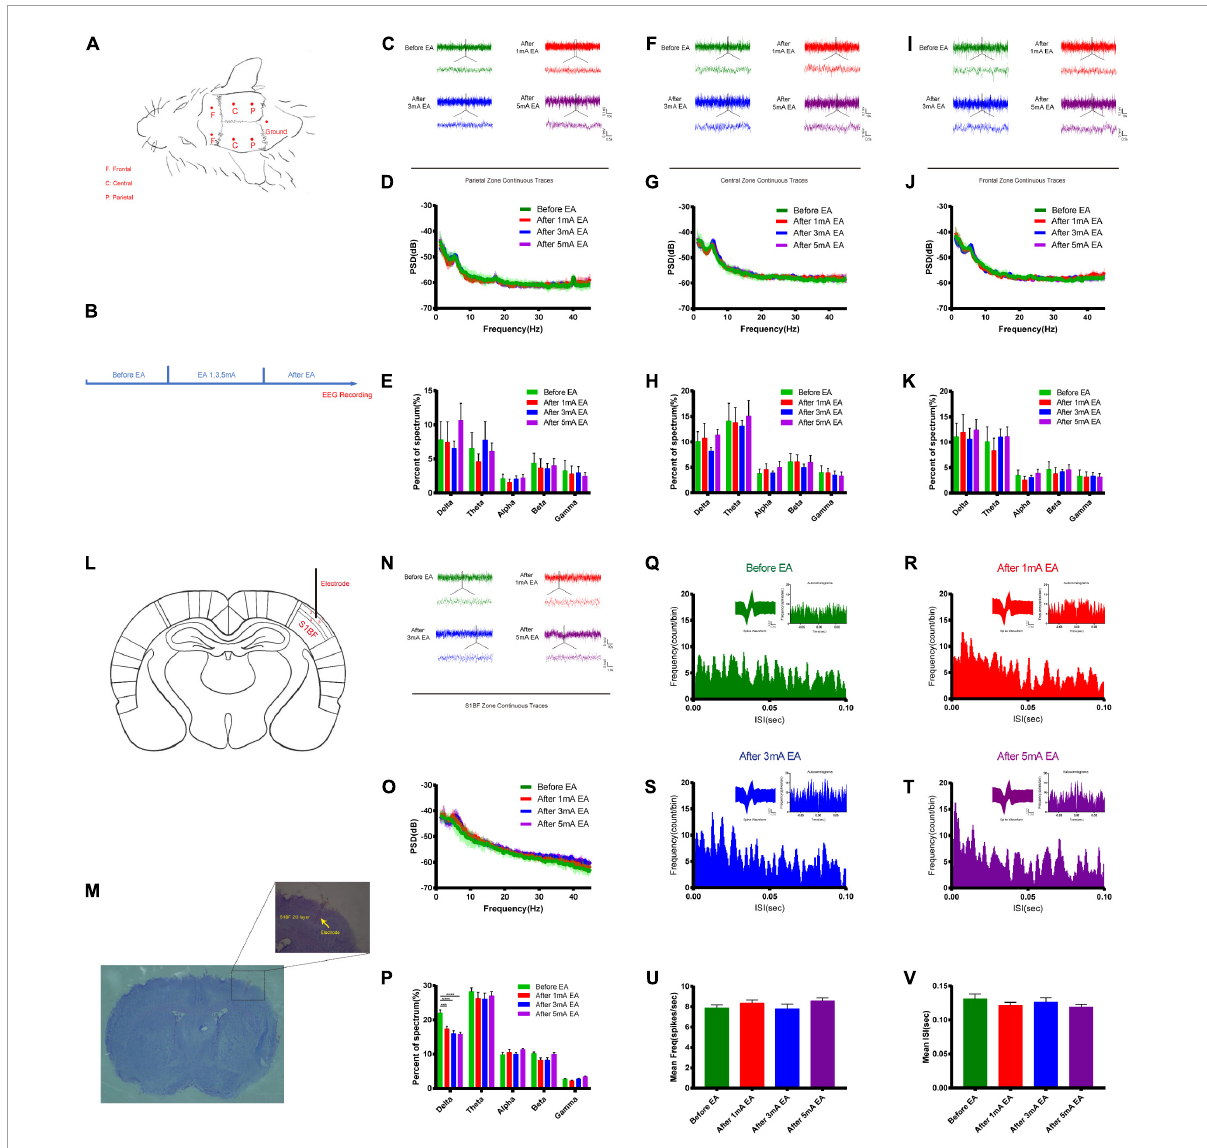
FIGURE6 Effect of different intensities of EA of trigeminal nerve on neuronal excitability changes in EEG. (A,B) EEG detection location and experimental flow. (C) Parietal zone continuous traces, 100 s of EEG data were selected in the stable state without interference for before EA and after EA groups (the EEG data during EA could not be used because of too much interference from electromagnetic radiation) and 5 s of data were captured for display. (D) PSD (power spectral density) in the parietal zone before and after EA at different intensities. There was no significant difference between the groups. (E) Parietal zone of each group for delta 1–3 Hz, theta 3–7 Hz, alpha 7–12 Hz, beta 12–30 Hz, and gamma 30–45 Hz frequency band percent of the spectrum (%), which showed that there was no significant difference. (F) Central zone continuous traces, 100 s of EEG data were selected and 5 s of data were captured, for display. (G) The PSD central zone before and after EA of different intensities. There was no significant difference between the groups. (H) Central zone for each group frequency band percent of the spectrum (%); there was no significant difference for each group. (I) Frontal zone continuous traces, 100 s of EEG data were selected and 5 s of data were captured for display. (J) The PSD frontal zone before and after EA of different intensities. There was no significant difference between the groups. (K) Frontal zone group frequency band percent of the spectrum (%); there was no significant difference for each group. Zone frequency band percent of the spectrum (%) for each group showed that there was no significant difference for each group, n = 5/group. (L,M) Electrode implantation in S1BF 2/3 layer zone (corresponding to the infraorbital nerve stimulation point). (N) S1BF zone continuous traces, 100 s of EEG data were selected and 10 s of data were captured for display. (O) PSD before and after different intensities of EA in the S1BF zone. (P) The group frequency band percent of the spectrum (%) showed that delta rhythm decreased after EA of the S1BF zone, *** P < 0.001, control group vs. 1 mA group, **** P < 0.0001, control group vs. 3 and 5 mA groups. (Q–T) The inter spike interval (ISI, bin = 0.05 ms) for different intensities of EA stimulation in the S1BF zone showed a typical waveform, and autocorrelograms indicated that the frequency of short ISI (less than 50 ms) increased with the increase in EA intensity. (U) The mean frequency of spike in unit time second for different intensities of EA stimulation in the S1BF zone for each group is shown, which indicates that there was no significant difference between the groups. (V) The mean ISI time for each group after EA of the S1BF zone, which showed no significant difference between the groups, n =